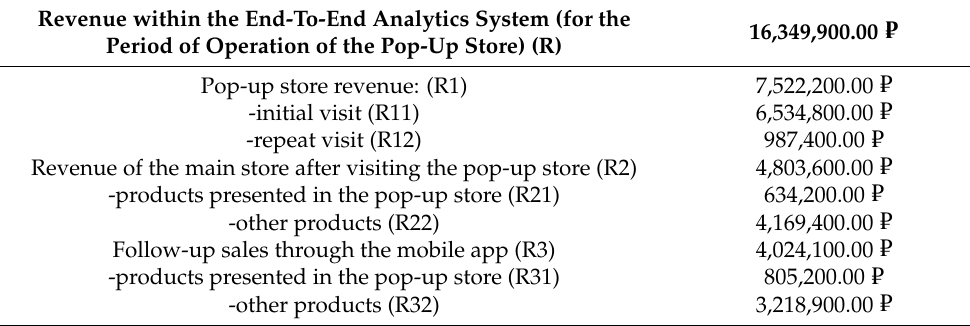
Table 4. Revenue based on the results of assessing the activities of the pop-up store. Revenue within the End-To-End Analytics System (for the Period of Operation of the Pop-Up Store) (R)